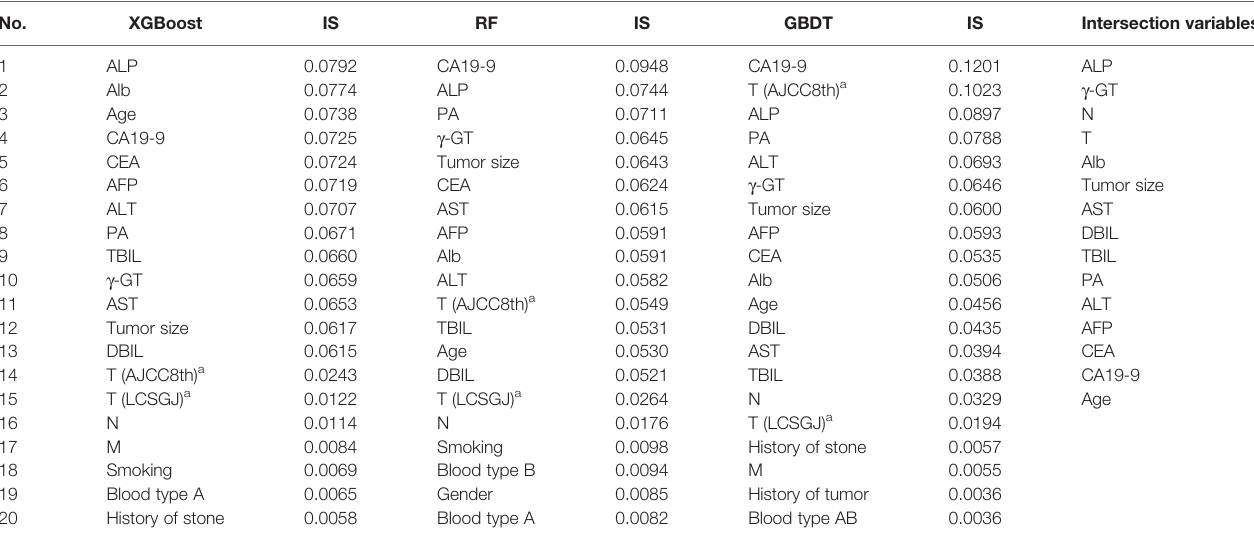
TABLE 2 | The important variables calculated by XGBoost, random forest (RF), and gradient boosted decision tree (GBDT), and their intersection